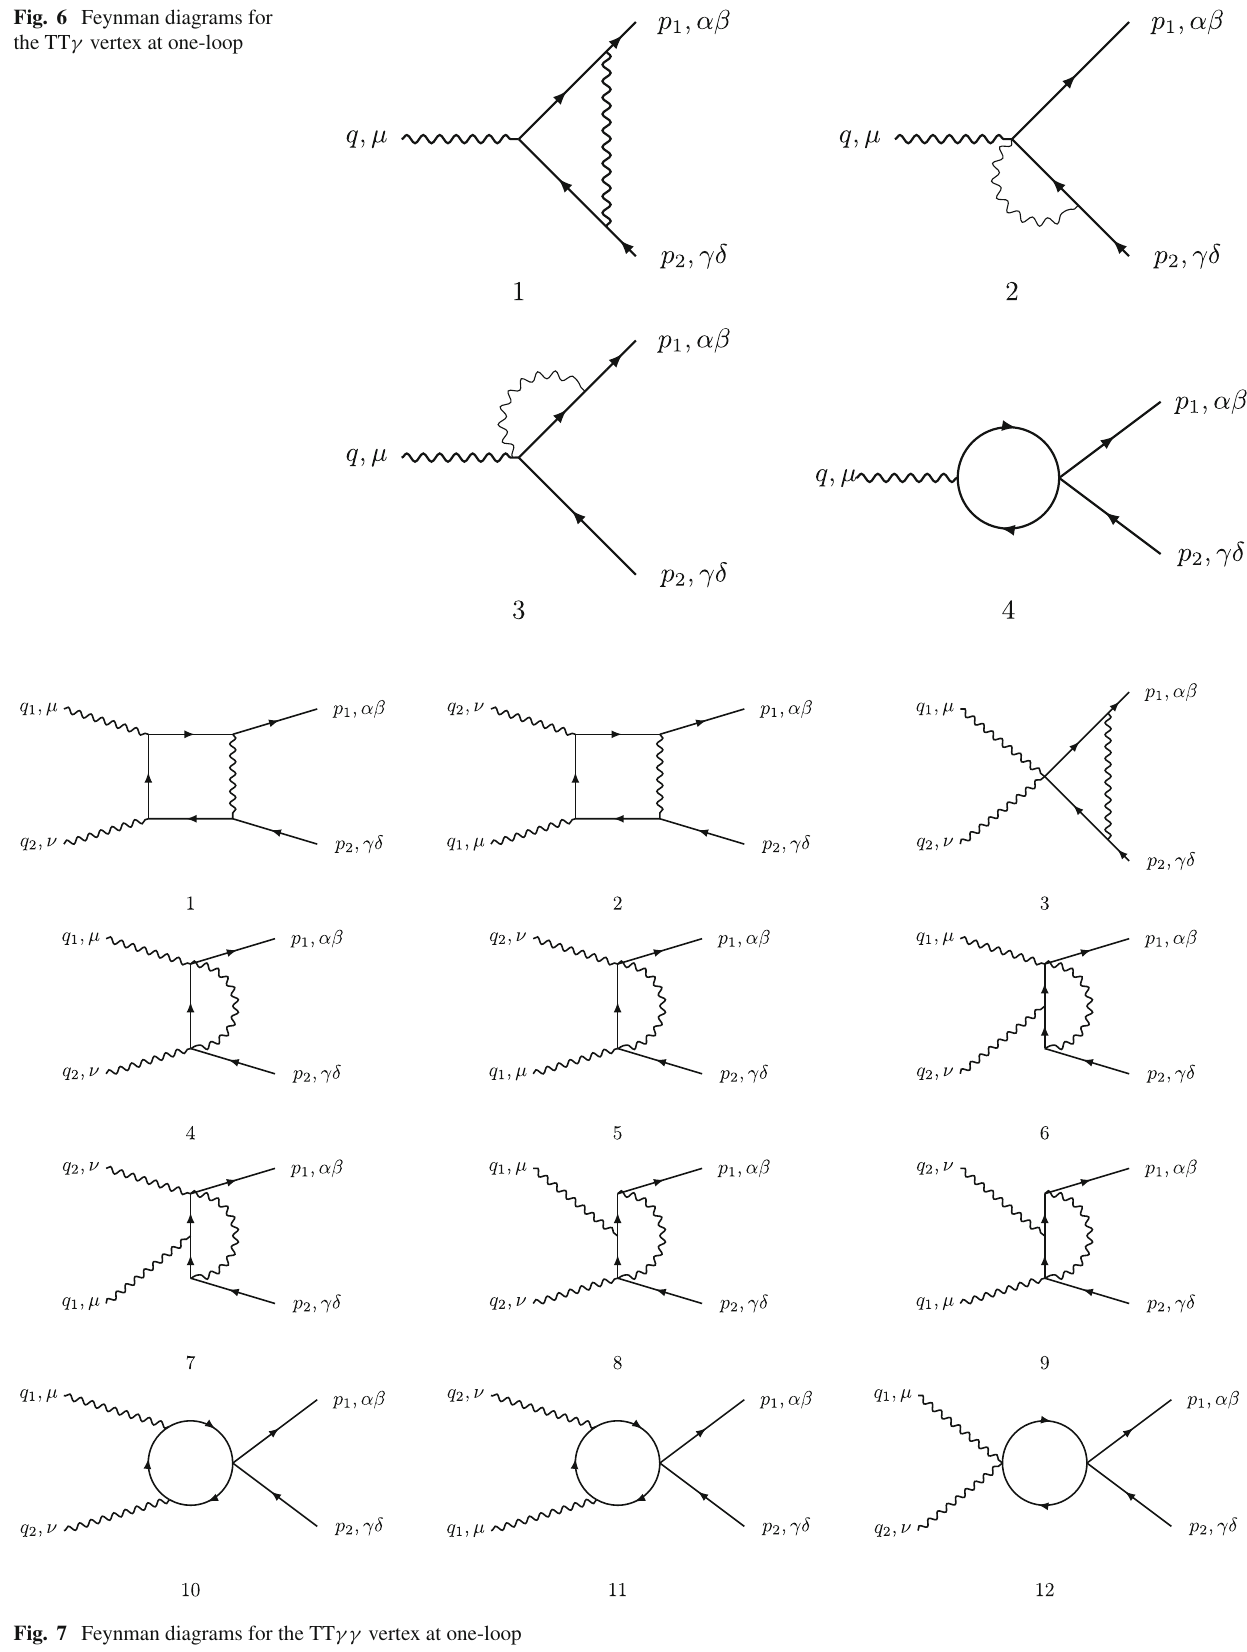
Fig. 7 Feynman diagrams for the TT γγ vertex at